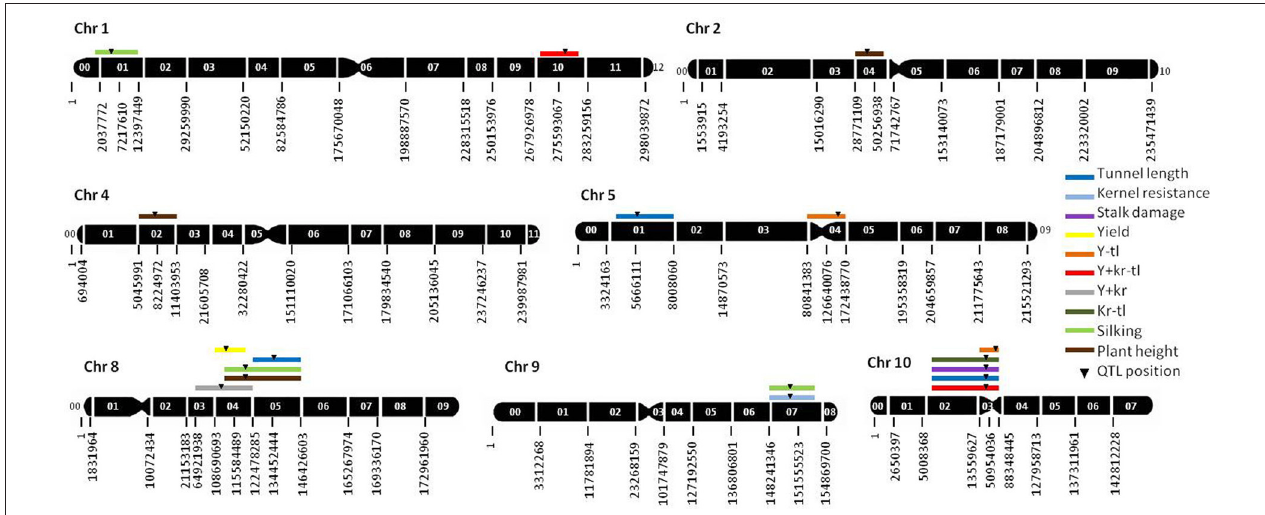
FIGURE 1 | Molecular linkeage map of maize based on 285 SNP markers and QTL positions. The genetic map was constructed on 162 RILs derived from the A637 × A509. Only those chromosomes where significant QTL were located are shown. The black numbers below each chromosome indicate the position in bp of each SNP marker, and the white numbers on each chromosome indicate the bin number. 95% confidence intervals are indicated by the length of the QTL bar. Y − tl, yield minus tunnel length index; Y + kr − tl, yield plus kernel resistance minus tunnel length index; Kr − tl, kernel resistance minus tunnel length index; Y + kr, yield plus kernel resistance index. Stalk damage was calculated in percent respect to plant height.